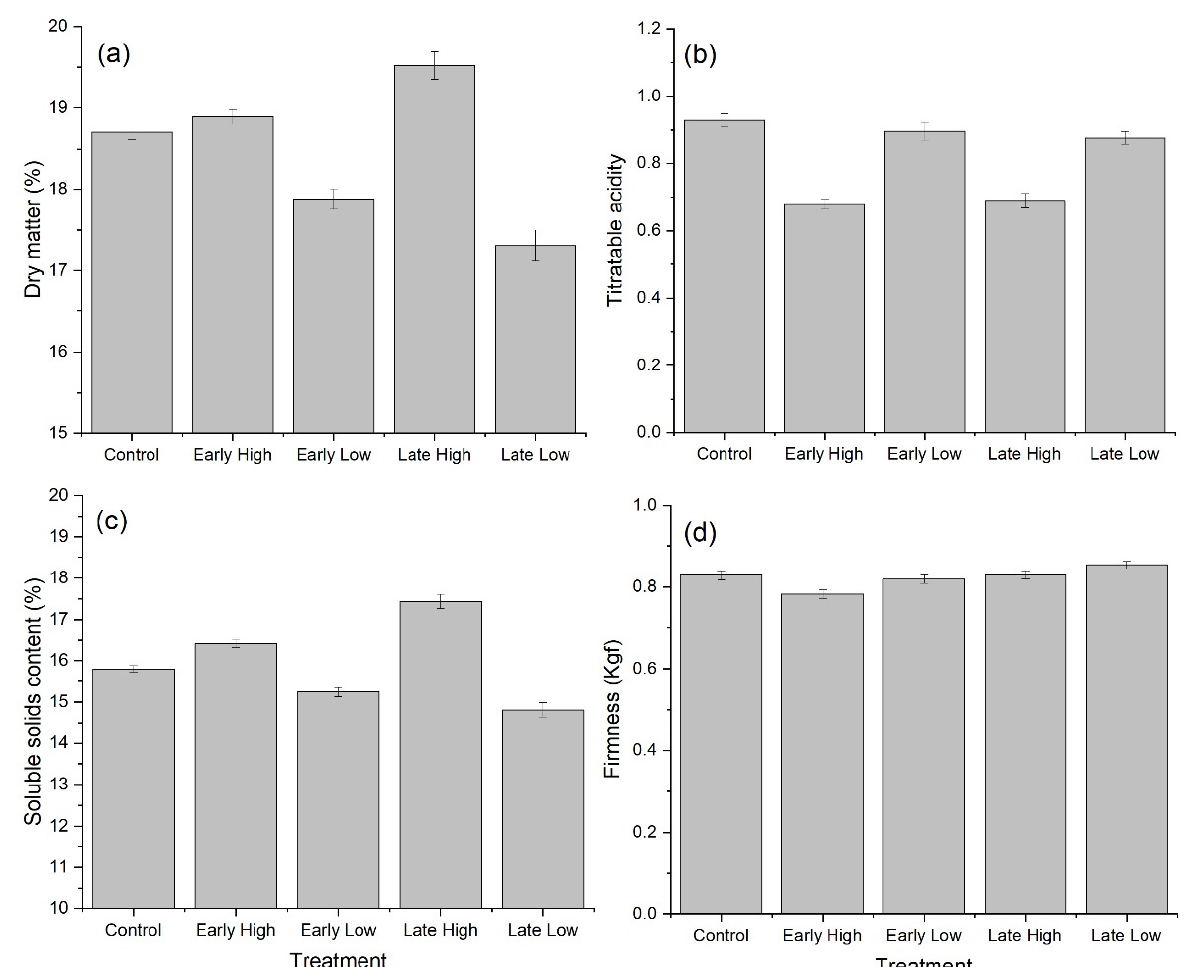
Figure 6. The effect of time of manipulation of carbohydrate supply together with phloem girdling on ( a ) dry matter ( b ) titratable acidity ( c ) soluble solids content and ( d ) firmness of Actinidia chinensis ‘Zesy002’ kiwifruit, in fruit used in the consumer sensory panel. Early girdled canes with High or Low carbohydrate supply or Late girdled canes with High or Low carbohydrate supply. Early treatments were applied at 38 days after anthesis and Late treatments were applied at 86 days after anthesis. Fruit were stored for 10 weeks at 2 °C for around 10 weeks and then ripened at 20 °C for up to 7 days before sensory analyses. High carbohydrate supply treatments had six leaves per fruit, while low carbohydrate supply treatments had one or two leaves per fruit. Data are means ± SEM, n = 75.